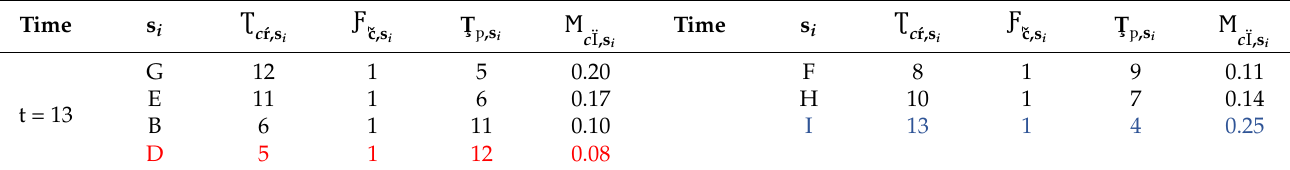
Algorithm 1: Determine the mature and immature content.